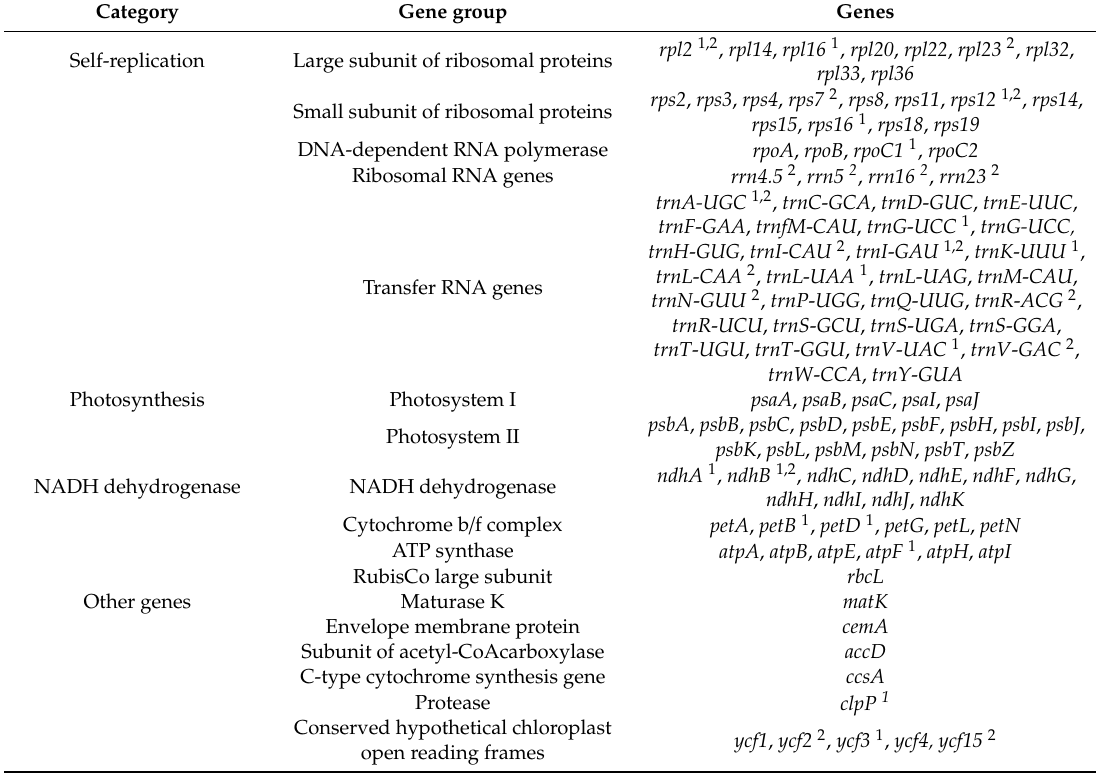
Table 2. List of the genes found in the plastid genome of A. camansi